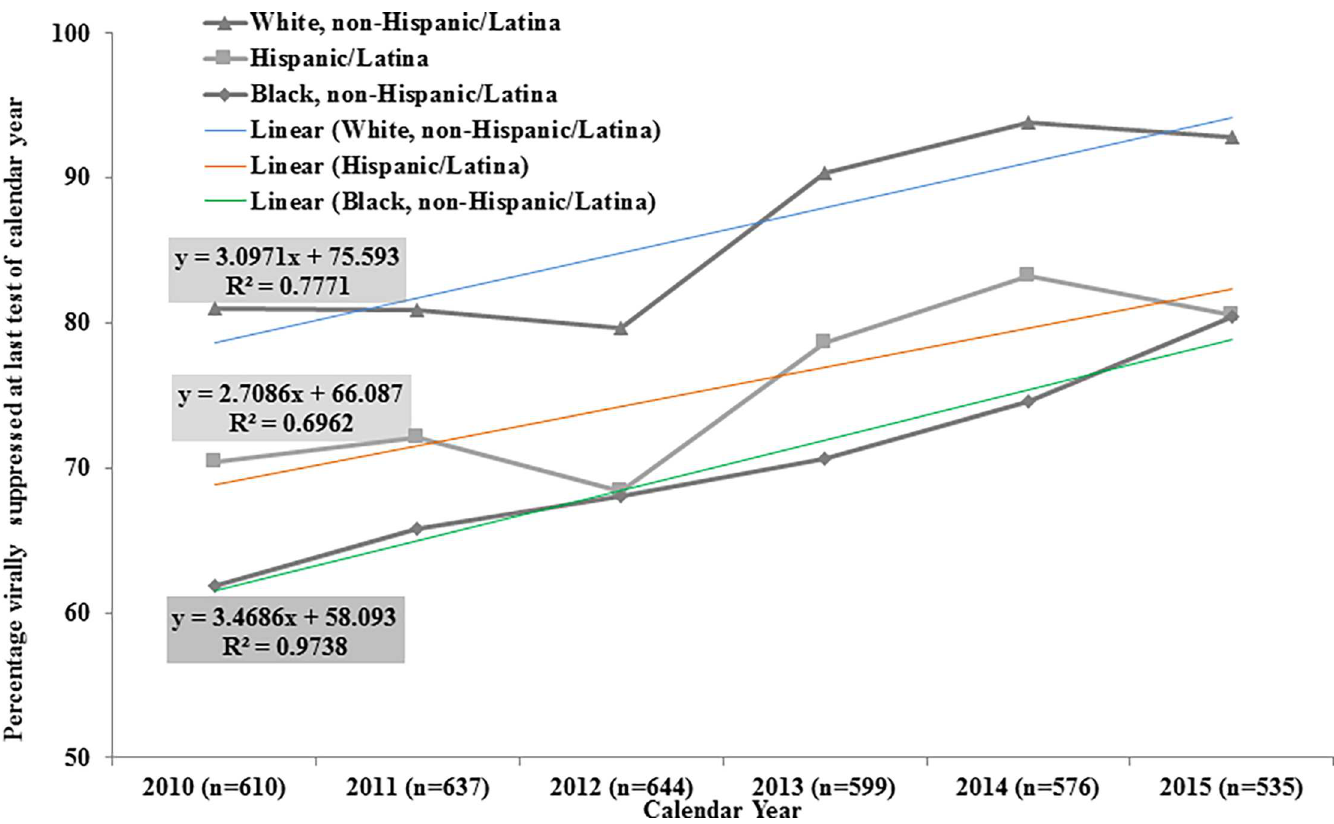
Fig 3. Trends of viral suppression by race/ethnicity, the HIV Outpatient Study, 2010–2015 (N = 809).